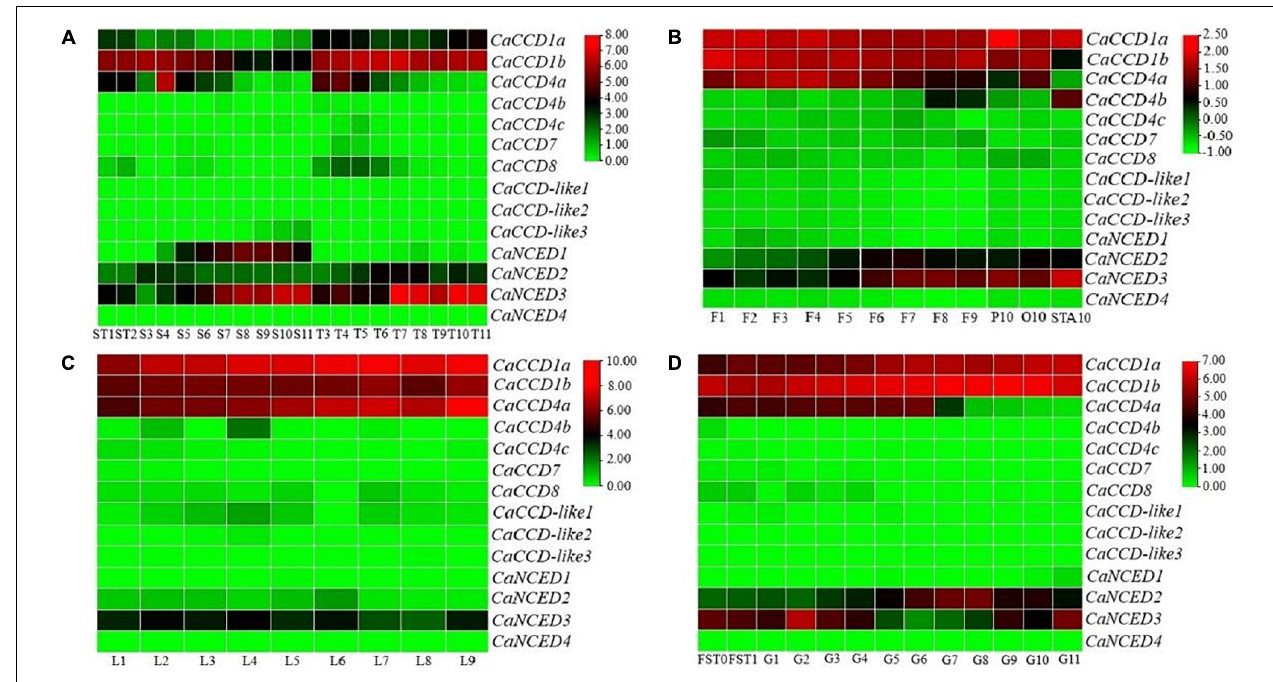
FIGURE 3 | Expression patterns of CaCCOs in different tissues of pepper. Key: red, strong expression; black, weak expression; green, no expression. The expression data were hierarchically clustered based on MeV software. (A) Seeds and placenta, (B) flowers, (C) leaf, and (D) fruit and